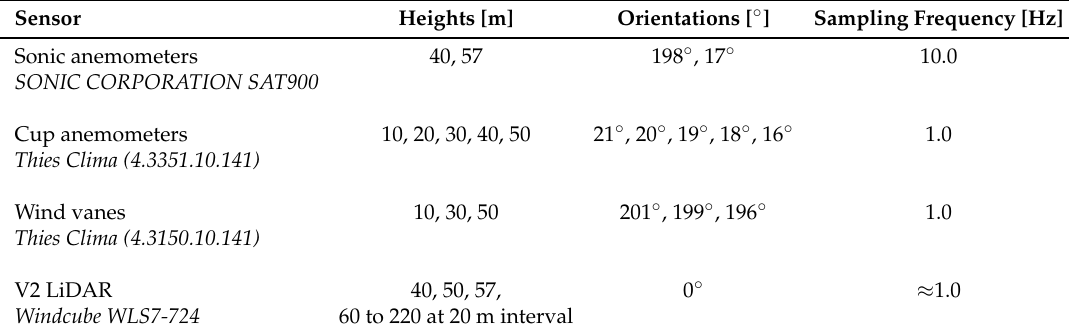
Table 1. Overview of wind speed and wind direction sensors installed at the FREA test site. For orientation, true north is set to 0 ◦ and the meteorological convention is